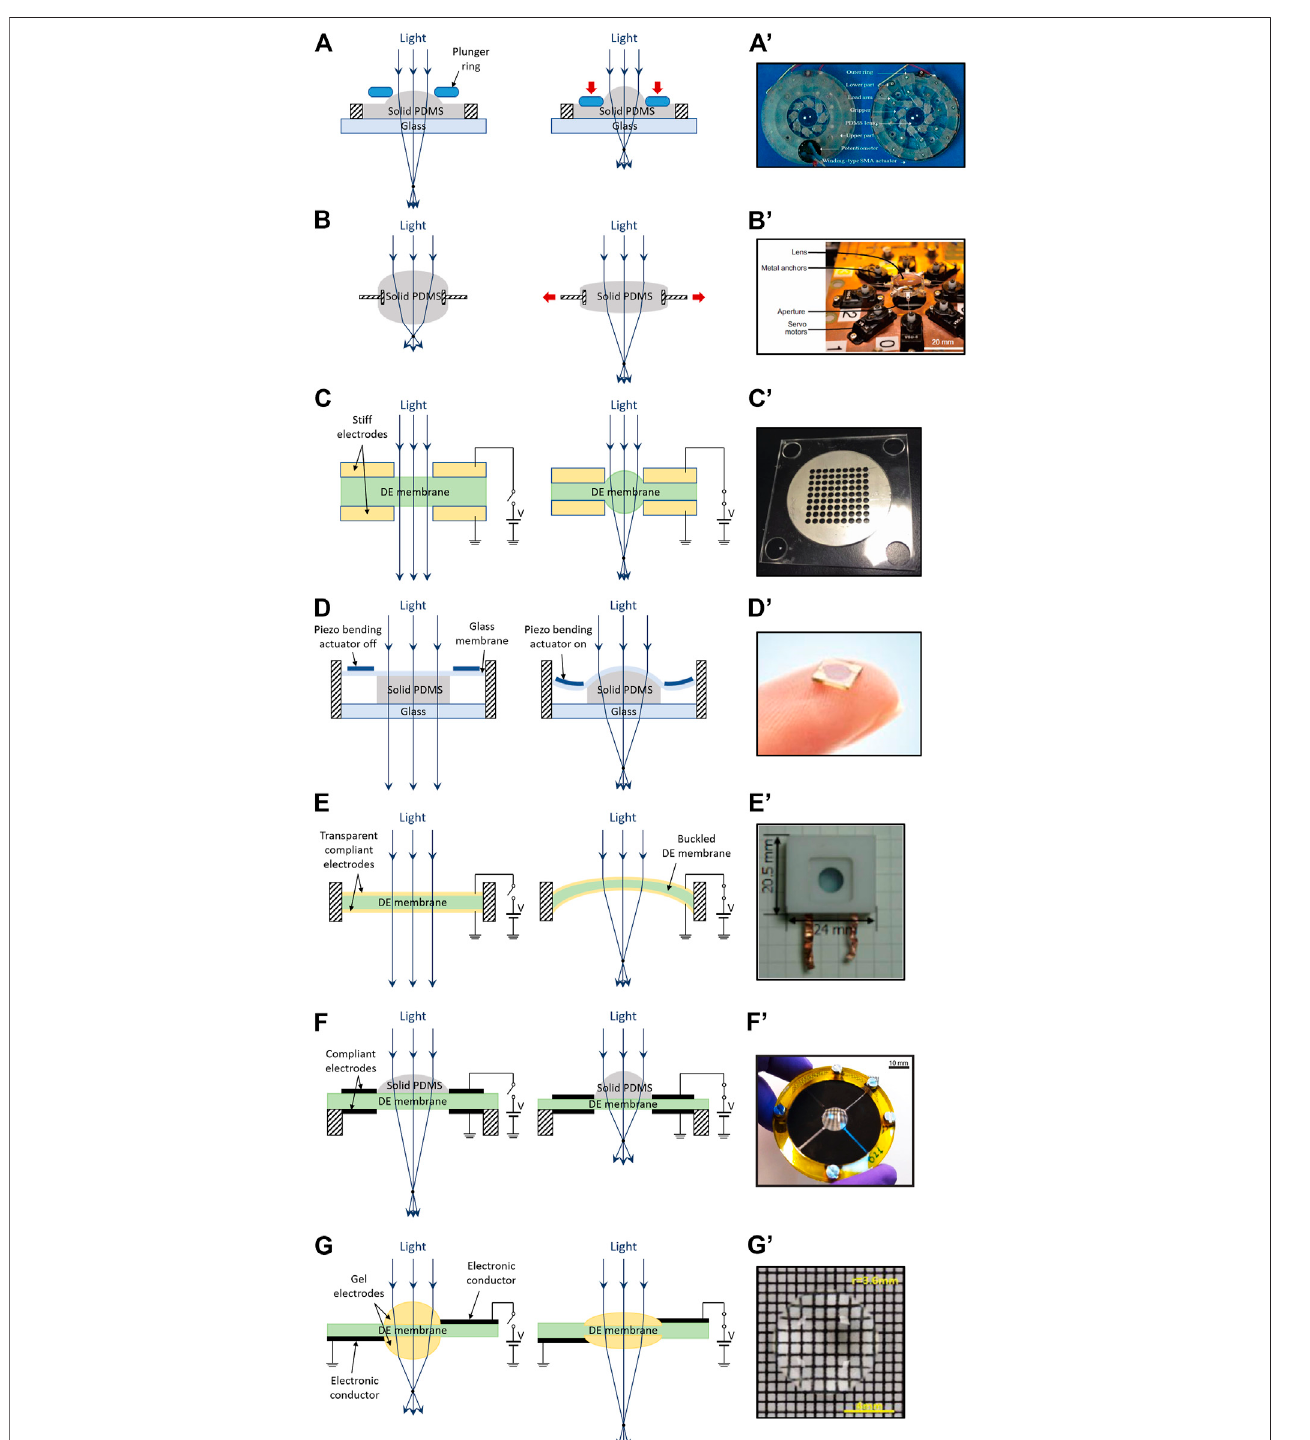
FIGURE7| Electro-mechanicallyshapedelastomericlenses.Structuresandprinciplesofoperation (left) andphotosofexamples (right) ,fordifferentactuationstrategies: (A) schematicof alenssqueezedbyanexternalplungerring; (A 9 ) shape-memory-alloy-actuatedprototypesample,reproducedwithpermissionfrom(Choietal.,2009); (B) schematicofalenspulledbyradial extenders; (B 9 ) servo-motors-actuatedprototypesample,reproducedwithpermissionfrom(Liebetrautetal.,2013); (C) schematicofalensoperatedbyanelectrostaticactuator,consistingofstiff annularelectrodesthatsqueezeasoftmembrane; (C 9 ) arrayofprototypesamples,reproducedwithpermissionfrom(Wangetal.,2017); (D) schematicofalensoperatedbypiezoelectric bendingactuators,whichdeformathinglassmembraneactingonthelens; (D 9 ) commercialproductbypoLight,adaptedfrom(Polight,2021); (E) schematicofalensoperatedbyatransparent DEactuator,whichformsthewholelensandincreasesitsowncurvaturebybuckling(note:unidirectionalbucklingshouldbefacilitatedbyaninitialasymmetry); (E 9 ) prototypesample,reproduced withpermissionfrom(Sonetal.,2012). (F) schematicofalensradiallycompressedbyanannularDEactuator; (F 9 ) prototypesample,reproducedwithpermissionfrom(Ghilardietal.,2019); (G) schematic of a lens made of and radially stretched by transparent gel electrodes of a DE actuator; (G 9 ) prototype sample, reproduced with permission from (Liu et al., 2020).